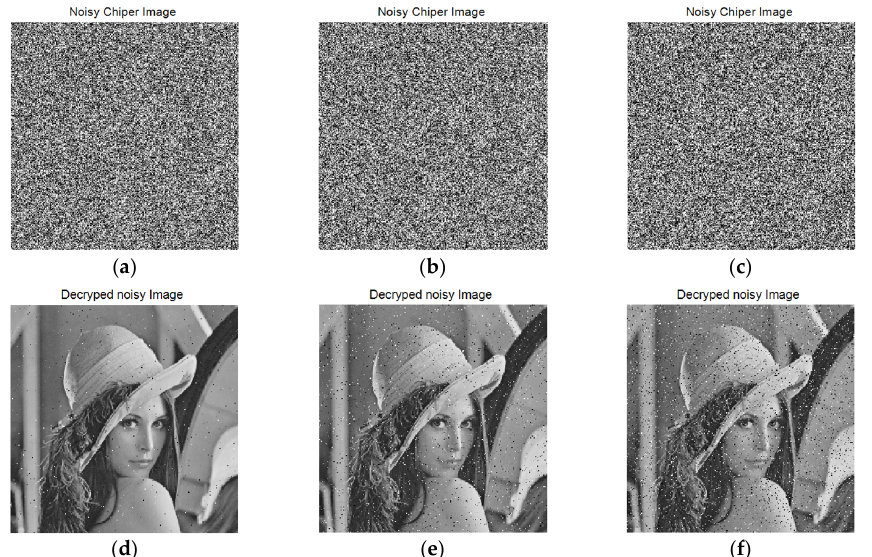
Figure 18. Noise attack test results: ( a – c ) noisy cipher image of different noise level; ( d – f ) decrypted noisy image.